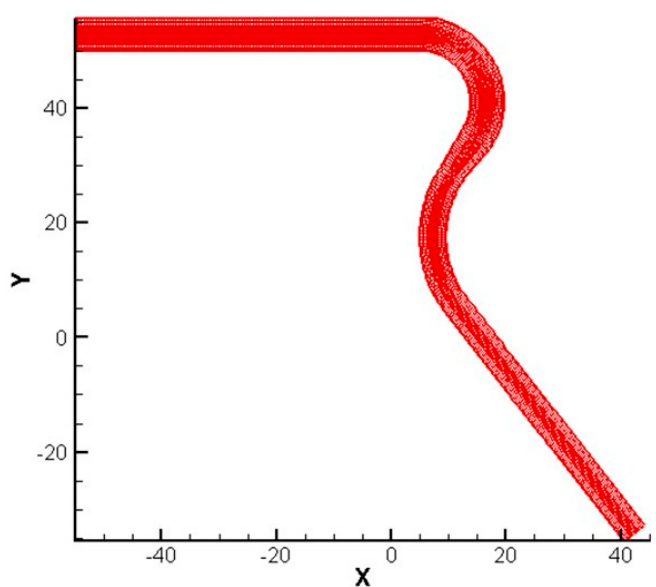
Figure A2. The structured mesh for the SRH-2D model has 326 cells in the downstream direction and 28 cells in the cross-stream direction.